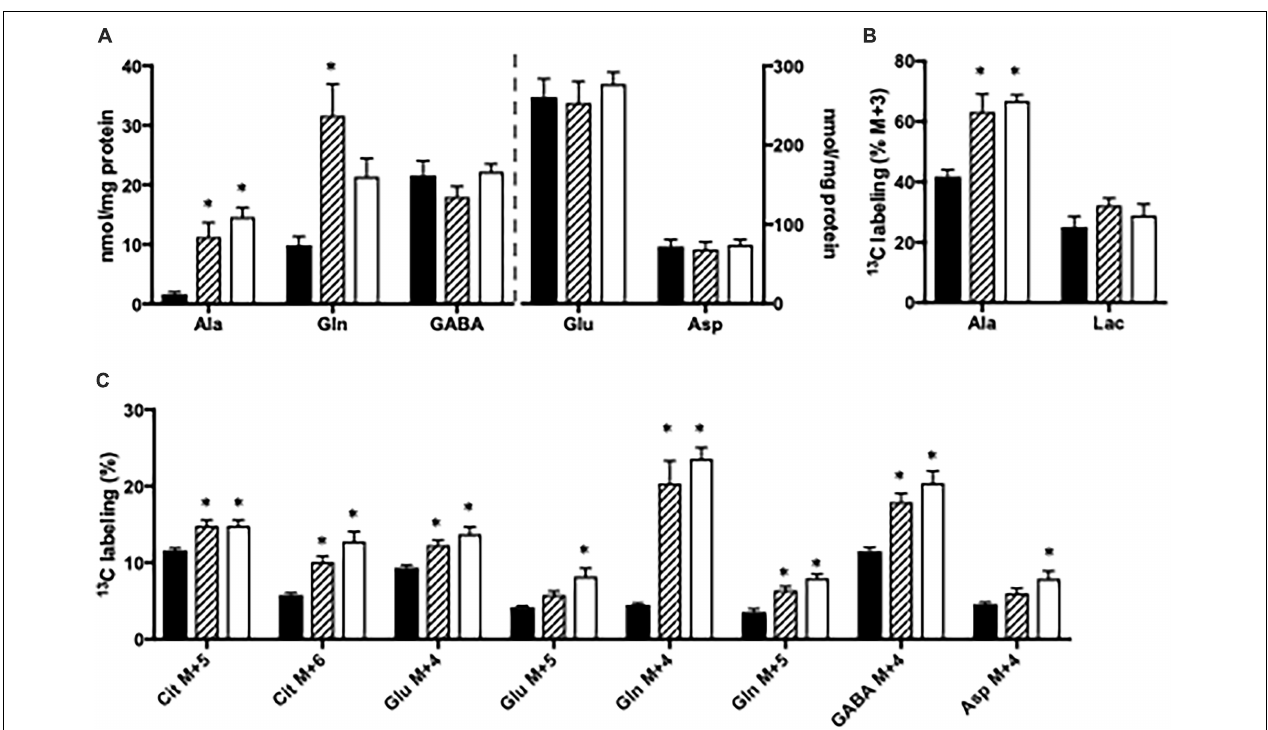
FIGURE 3 | Hippocampal slices from Glud1 lox / lox mice were incubated in medium containing 5 mM [U- 13 C]glucose and 0 mM (control; filled bars), 1 mM (hatched bars), or 5 mM (open bars) NH 4 Cl. The effect of ammonia treatment on the amounts (nmol/mg protein) of alanine, glutamine, GABA, glutamate, and aspartate (A) and the percent 13 C labeling originating from [U- 13 C]glucose in alanine M + 3 and lactate M + 3 (B) and in citrate M + 5, citrate M + 6, glutamate M + 4, glutamate M + 5, glutamine M + 4, glutamine M + 5, GABA M + 4, and aspartate M + 4 (C) . The hippocampal slices from Glud1 lox / lox mice were incubated in the presence of [U- 13 C]glucose for 60 min as detailed in Materials and methods. The amounts of metabolites were determined employing HPLC while the percent enrichment was determined from GC-MS analysis of slice extracts as detailed in Materials and methods. Results are averages ± SEM ( n = 6–10), and the asterisk indicates a statistically significant difference between hippocampal slices from Glud1 lox / lox mice incubated in the absence and presence of 1 or 5 mM NH 4 Cl ( P < 0.05). Ala, Alanine; Lac, Lactate; Cit, Citrate; Glu, Glutamate; Gln, Glutamine; GABA, γ -aminobutyric acid; Asp,